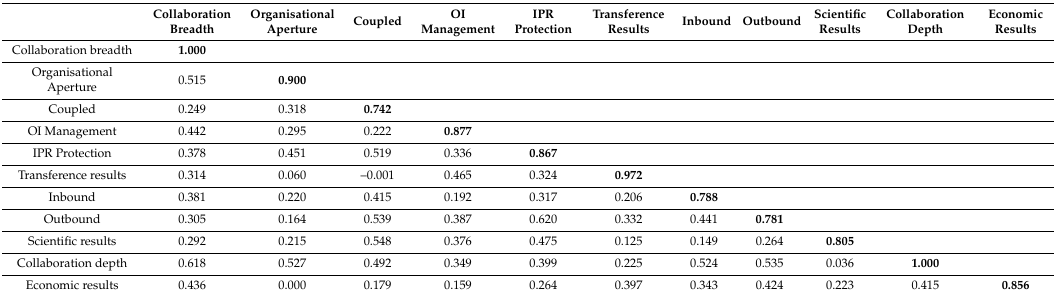
Table 6. Discriminant validity. Fornel–Larckert criteria.